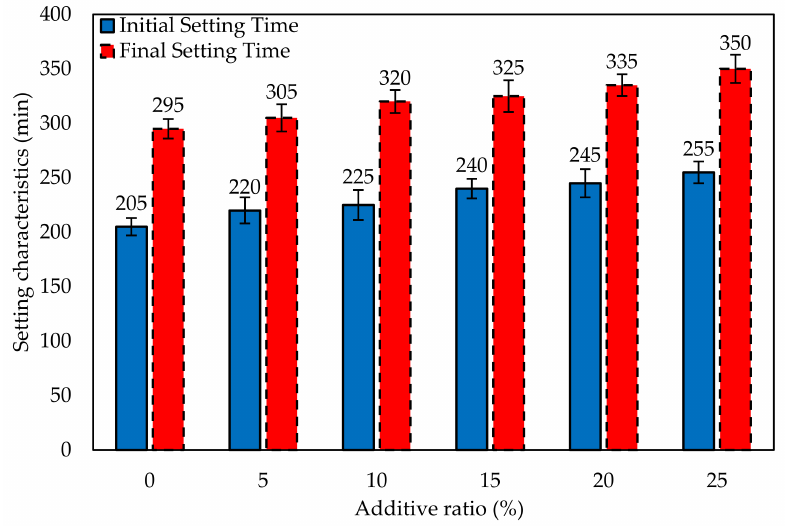
Figure 2. Setting characteristics of cement